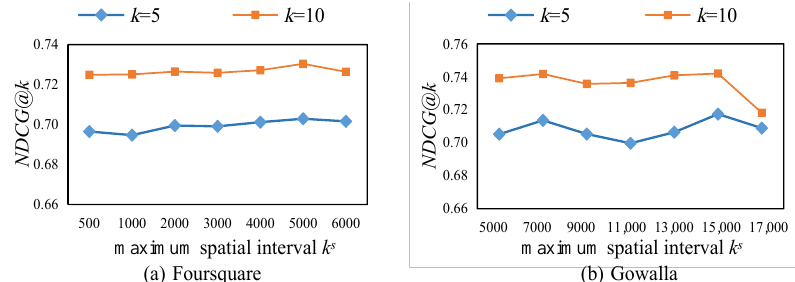
Figure 8. Effect of maximum spatial interval k s on recommendation performance.